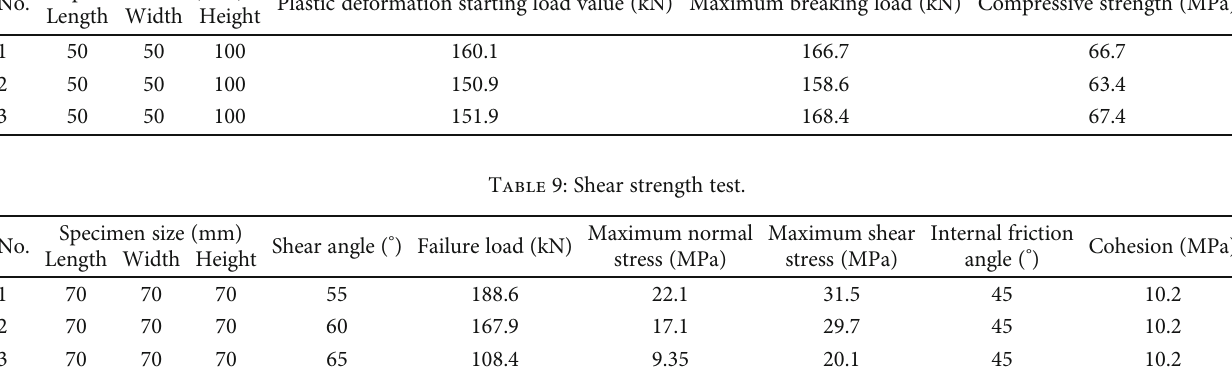
Table 8: Uniaxial compressive strength test.